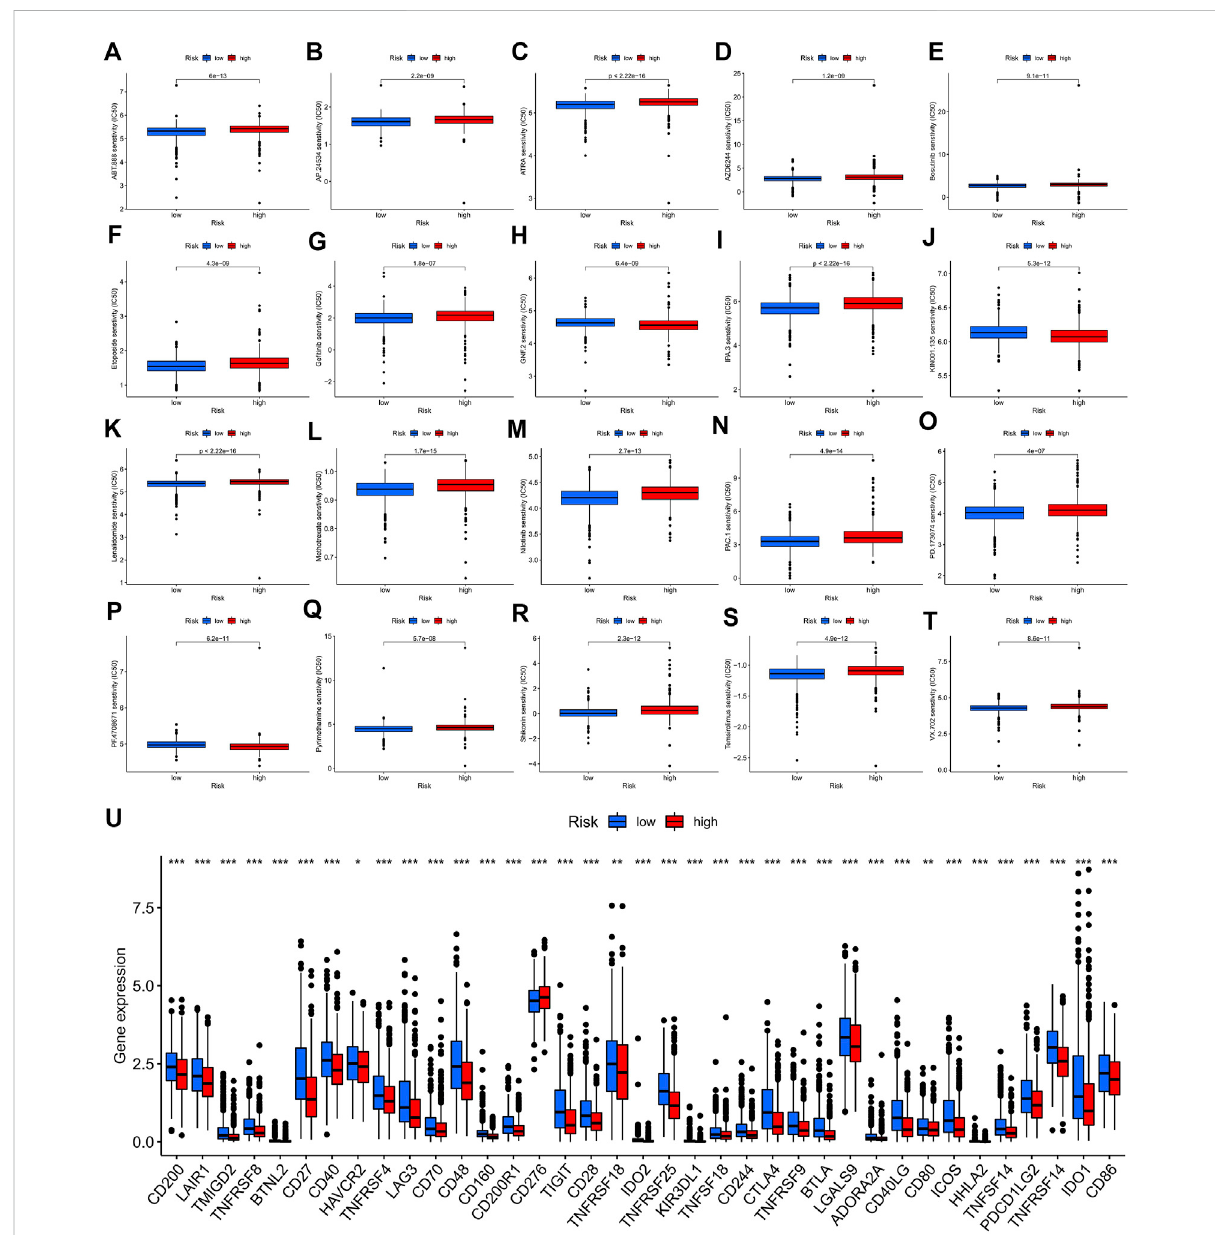
FIGURE 10 Potential drug sensitivity analysis by IC50 and the immune checkpoint gene expression analysis between the high- and low-risk groups. (A – T) The boxplots for the drug sensitivity analysis of (A) ABT.888. (B) AP.24534. (C) ATRA. (D) AZD6244. (E) Bosutinib. (F) Etoposide. (G) Ge fi tinib. (H) GNF.2. (I) IPA.3. (J) KIN001.135. (K) Lenalidomide. (L) Methotrexate. (M) Nilotinib. (N) PAC.1. (O) PD.173074. (P) PF.4708671. (Q) Pyrimethamine. (R) Shikonin. (S) Temsirolimus. (T) VX.702. Top 20 signi fi cantly associations were displayed, as determined by the p -value. (U)